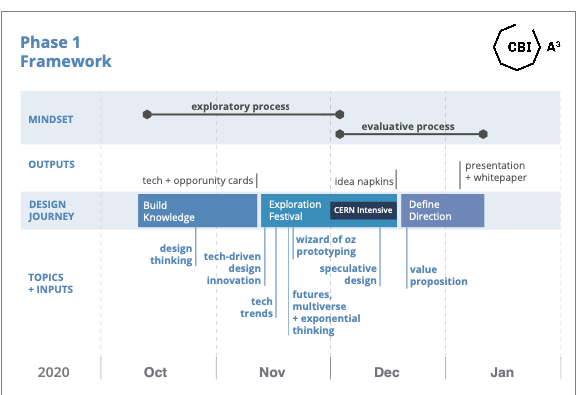
Fig. 2. Phase 1 Framework for CBI A 3